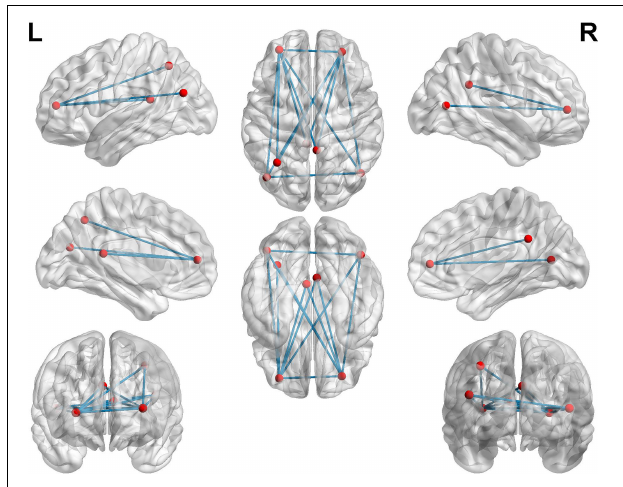
FIGURE 4 | Functional connectivities alterations in the AD patients relative to controls using seed-based interregional correlation analysis.